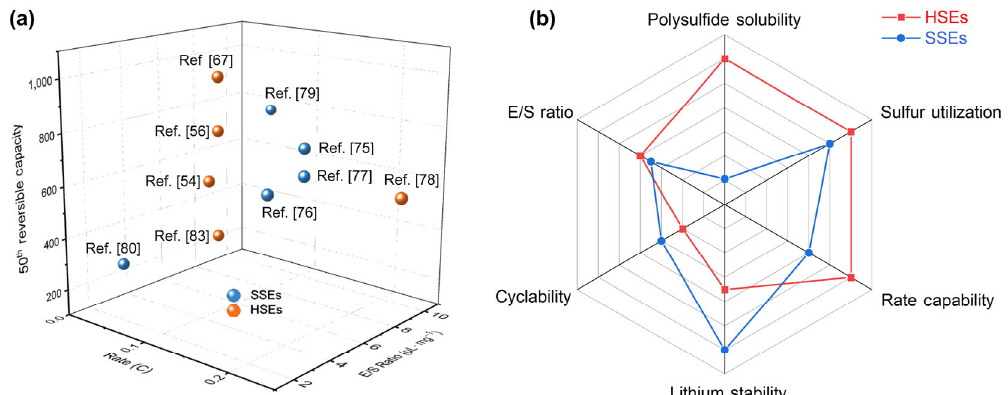
Figure 5 (a) Performance comparison of some typical HSEs and SSEs in high loading and lean-electrolyte Li–S batteries. (b) Radar chart comparison of Li–S batteries with HSEs and